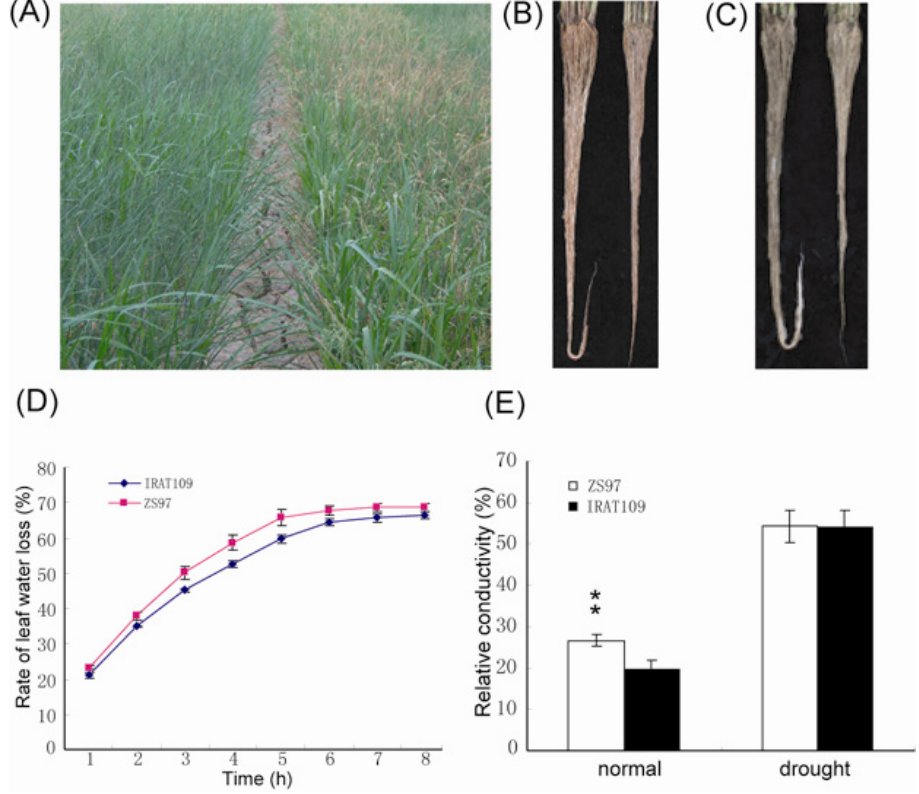
Figure 1. The performance of ZS97 and IRAT109 under normal and drought conditions. ( A ) Performance of ZS97 and IRAT109 under drought stress. Left: IRAT109, right: ZS97; ( B , C ) Root under normal and drought conditions, respectively. Left: IRAT109, right: ZS97; ( D ) Rate of leaf water loss of ZS97 and IRAT109; ( E ) Relative conductivity of leaves from ZS97 and IRAT109 under normal and drought